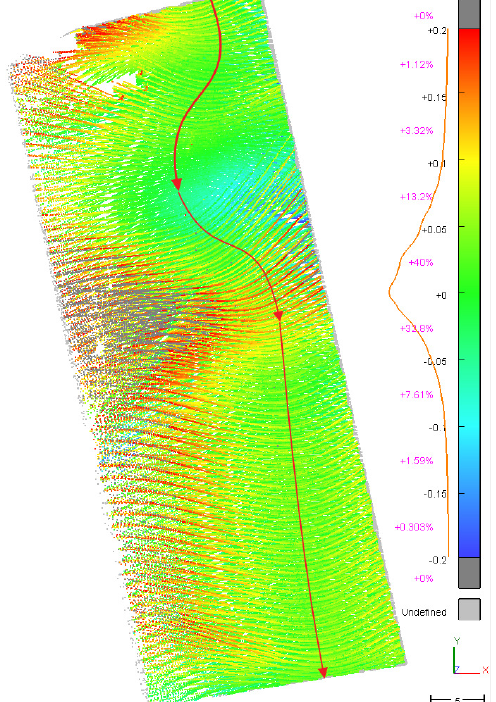
Figure 6. Vertical discrepancies between the TLS and MLS data gathered during a swerving manoeuvre. The red arrowed line denotes the trajectory of the